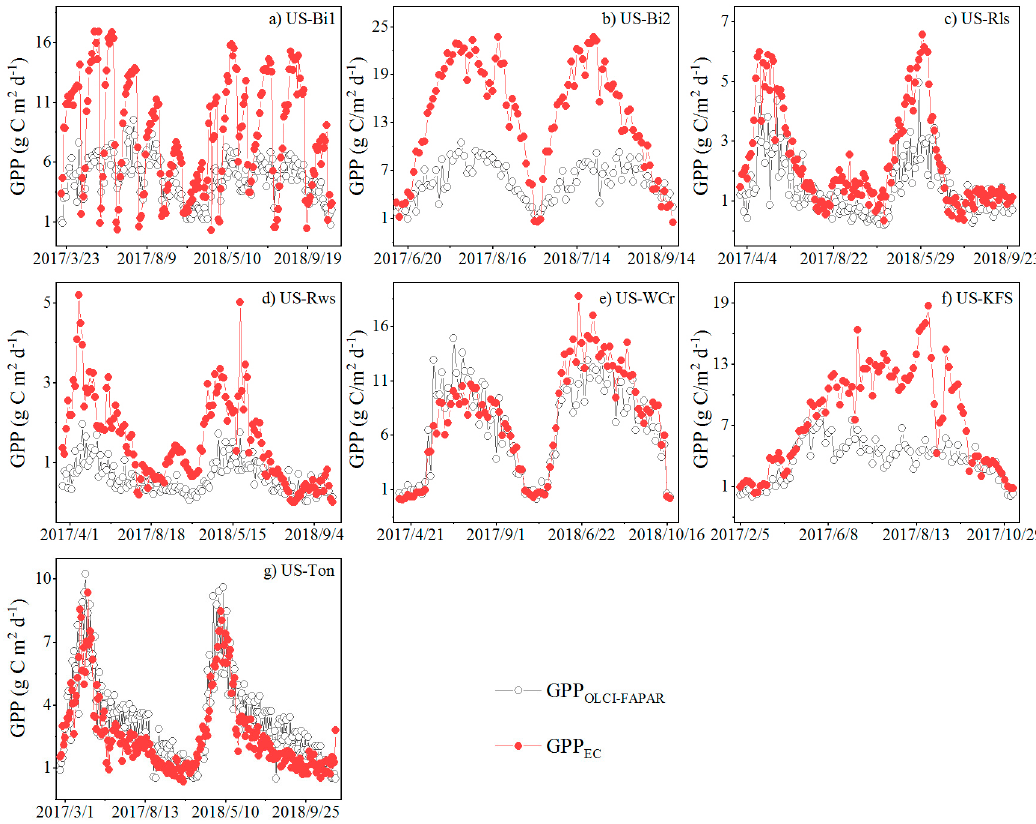
Figure 6. Temporal dynamics of GPP EC and GPP OLCI-FAPAR for all sites in 2017 and 2018.